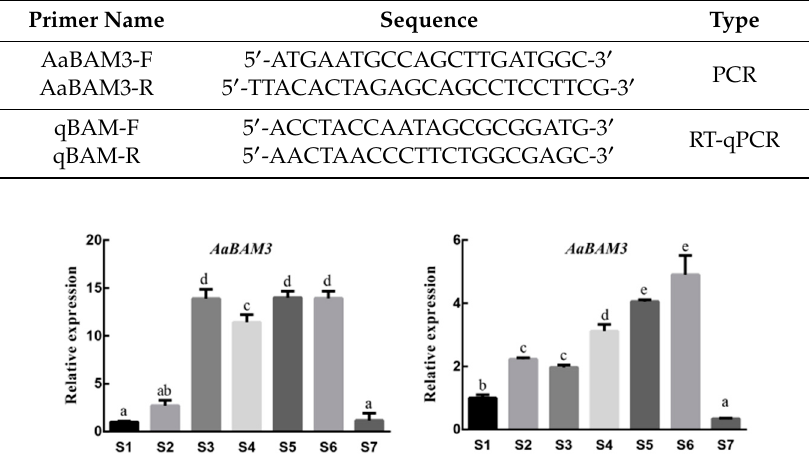
Table 3. The sequences of primers used in this paper.